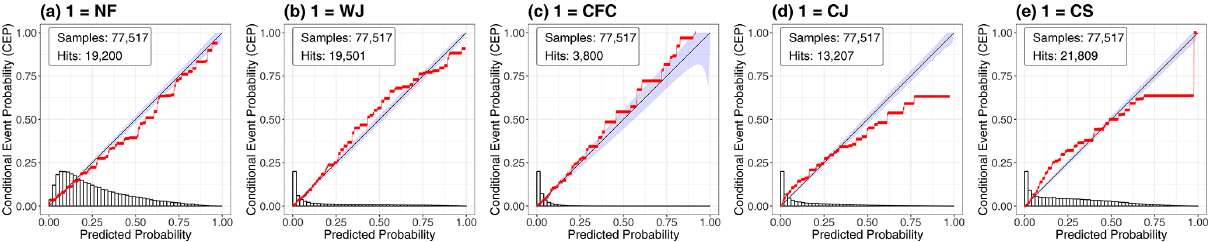
Figure D2. As in Fig. 6 but based on COSMO-REA6 data.